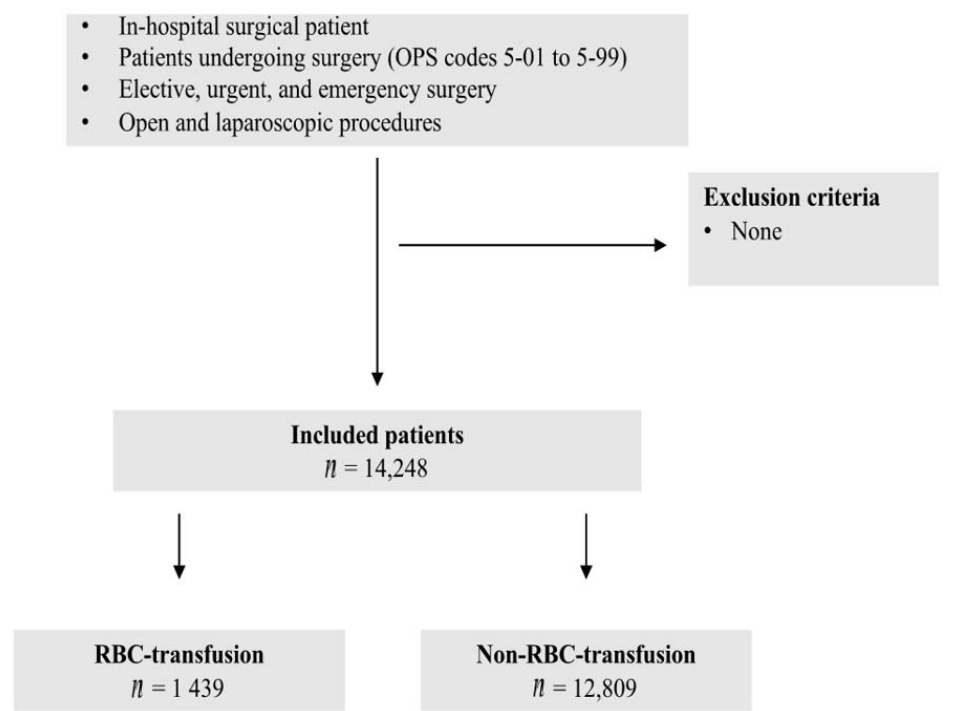
Figure 1. Flowchart of patient selection process.